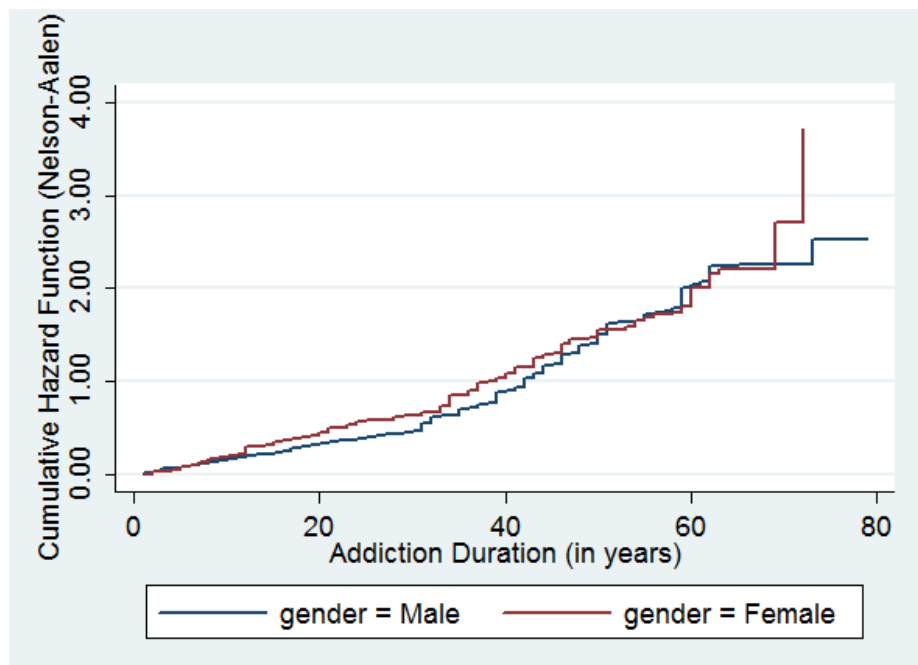
Figure 2. Cumulative hazard of quitting a tobacco addiction. Source: Authors’ calculations.